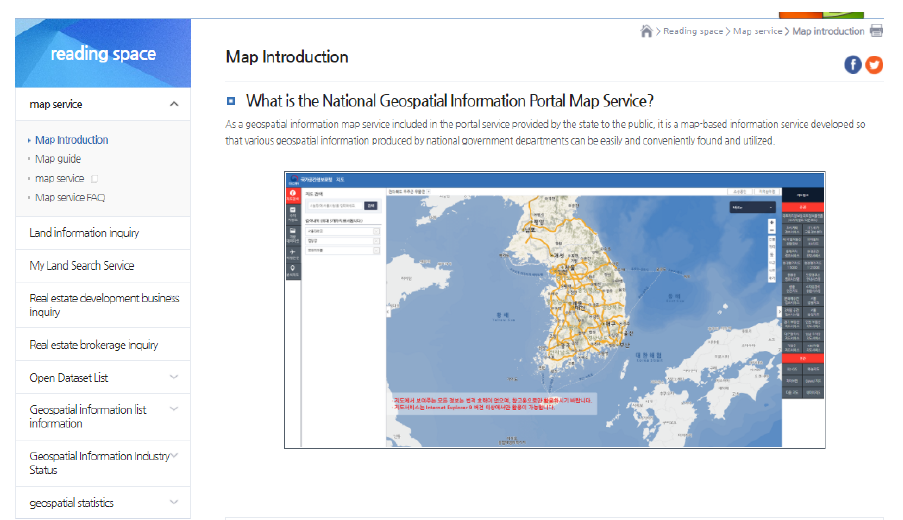
Figure 8. Map-based information provided in ‘reading space’.